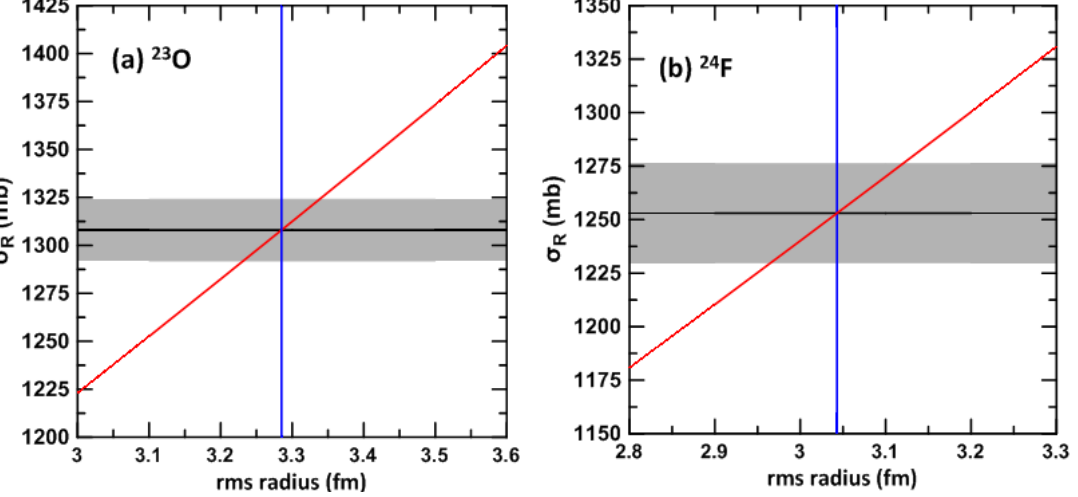
Fig.5: The reaction cross section versus the matter rms radii for the halo nuclei 23 O and 24 F.